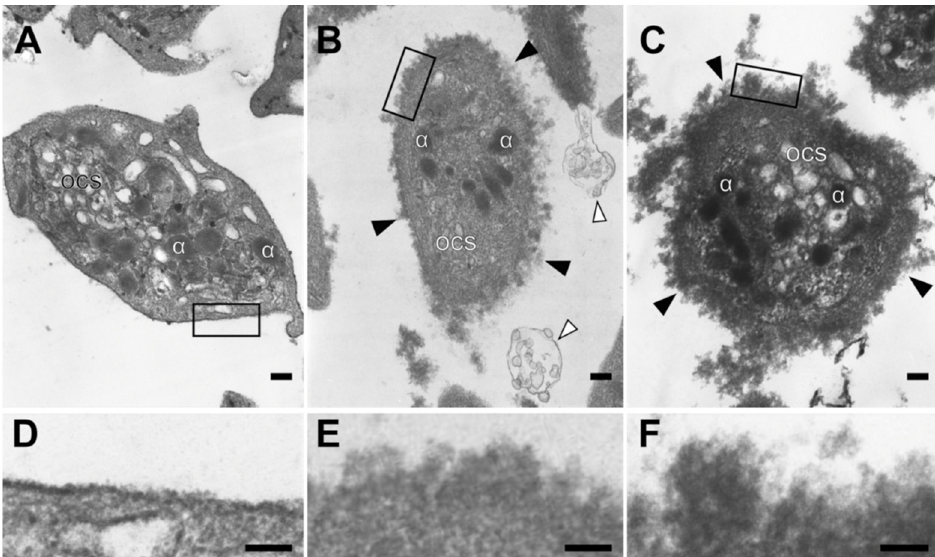
Figure 3. Representative transmission electron micrographs showing ultrastructural alterations of platelets in SLE. Platelets were isolated from the blood of a healthy donor ( A ) and SLE patients without ( B ) and with ( C ) the antiphospholipid syndrome, showing ultrastructural alterations of platelets in SLE. Black arrowheads indicate the altered plasma membrane, and white arrowheads indicate plasma-membrane-derived multivesicular structures. ( D – F ) Corresponding zoomed-in areas of interest from ( A – C ) are marked with a rectangle, illustrating an abnormally rough and shaggy platelet membrane in SLE. Designations: α — α -granules; OCS—open canalicular system. Scale bars = 200 nm ( A – C ) and 100 nm ( D – F ).